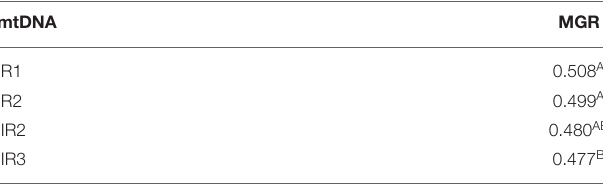
Values followed by different letters in a column are significantly different from each other at P = 0.05.